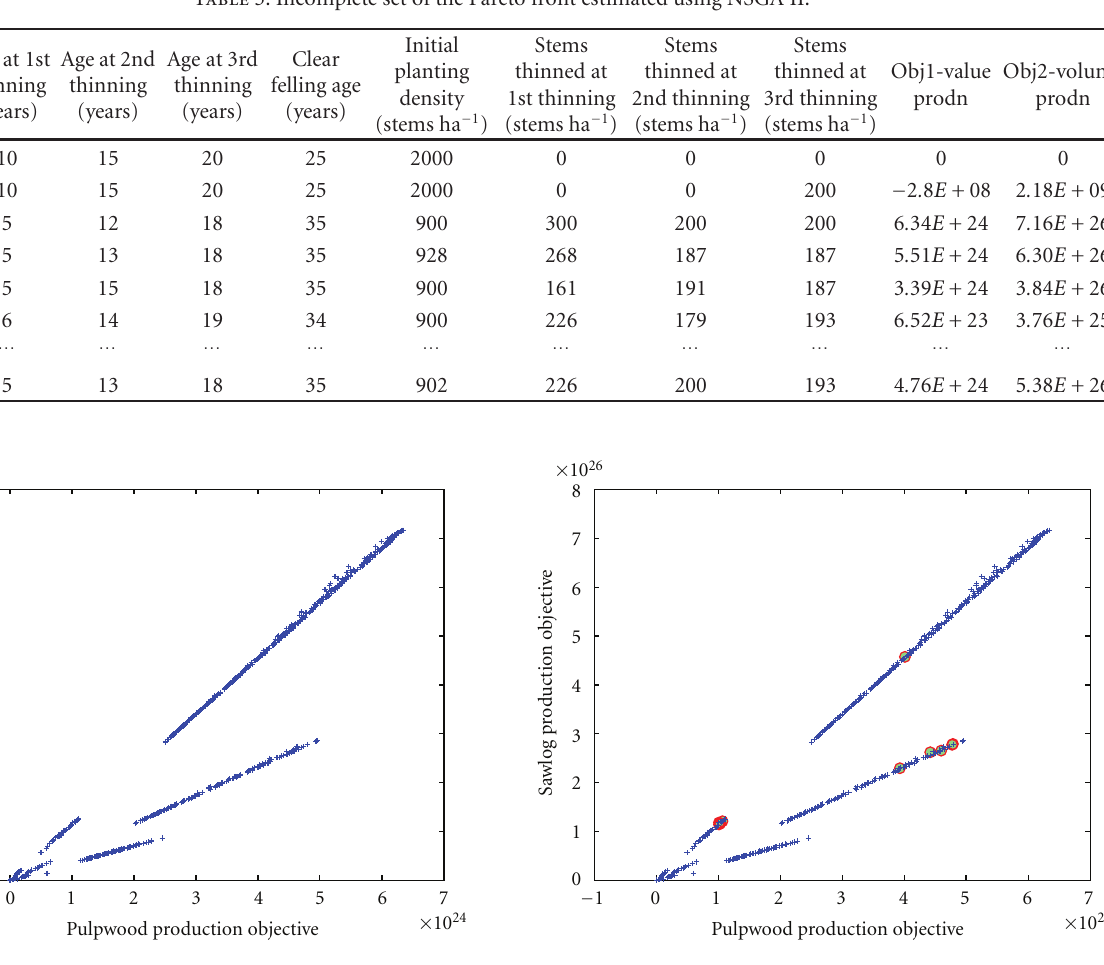
Table 5: Incomplete set of the Pareto front estimated using NSGA II.